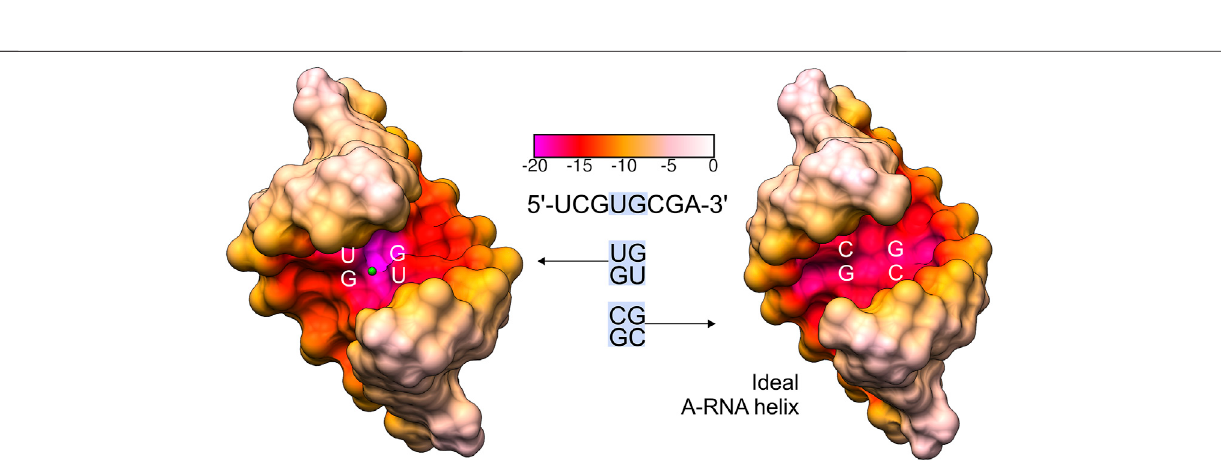
FIGURE5| Comparisonofthemajorgrooveelectrostaticpotentialinthepresented5 ′ UG/3 ′ GUwobbletandem(motifI)andidealA-helixRNAcontainingcanonical 5 ′ CG/3 ′ GCcounterparts (generated using Coot software)(Emsleyet al., 2010).Ba 2+ isshown asa greenball . Theelectrostatic surface wascalculated using theAPBS/ PDB2PQR server (default settings) (Baker et al., 2001; Dolinsky et al., 2004; Jurrus et al.,